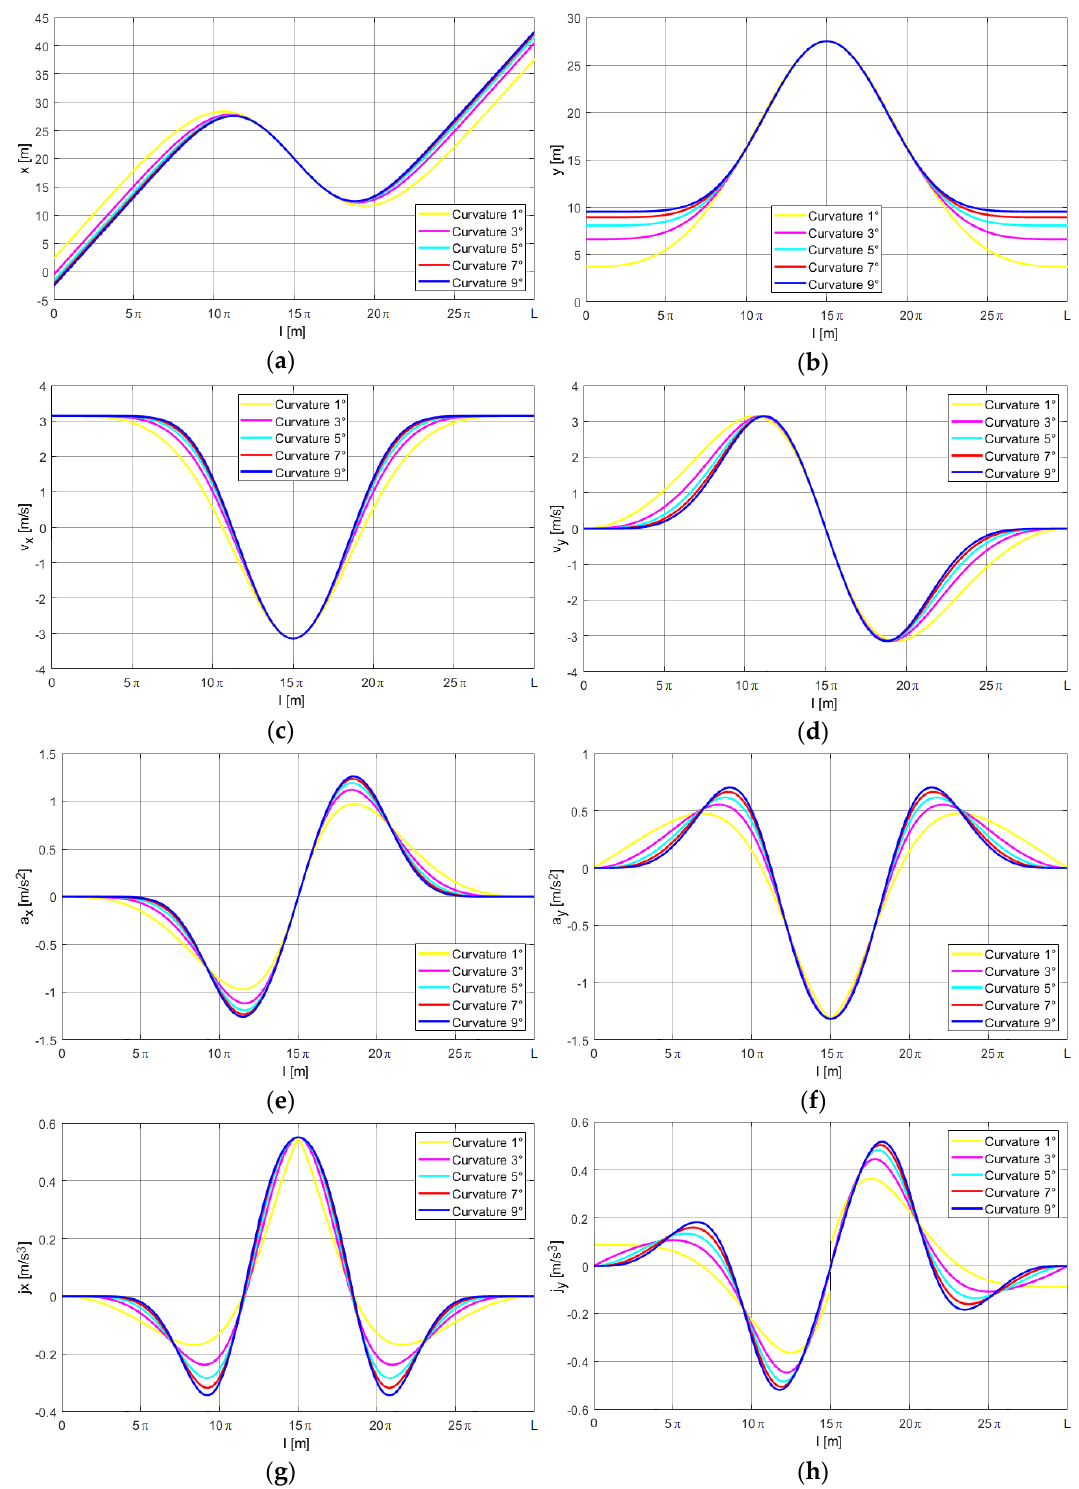
Figure 14. The course of the kinematic quantity components for the OMG trajectory: ( a ) displacement along the axis x; ( b ) displacement along the axis y; ( c ) velocity along the axis x; ( d ) velocity along the axis y; ( e ) acceleration along the axis x; ( f ) acceleration along the axis y; ( g ) jerk along the axis x; ( h ) jerk along the axis y.